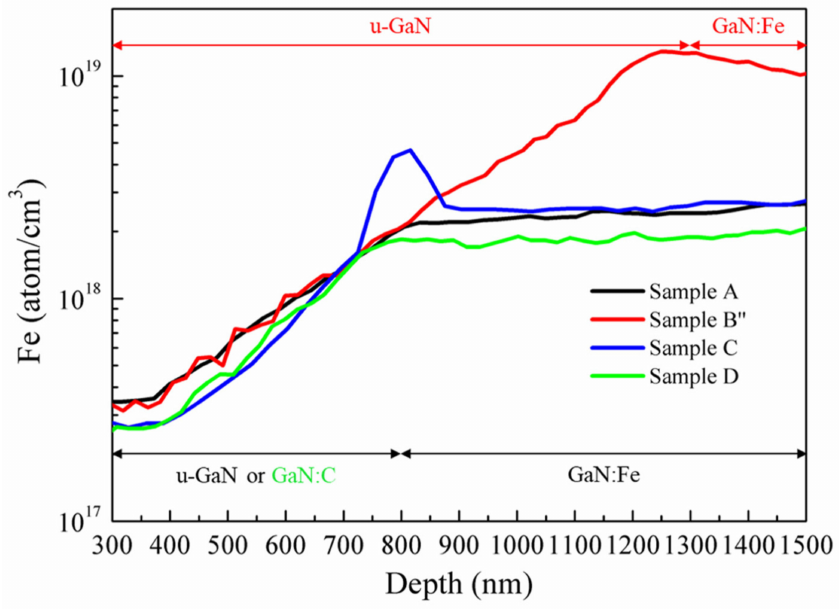
Figure 4. Fe concentration profile measured by SIMS for four different